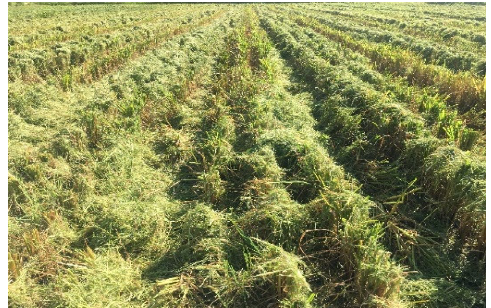
Figure 3. Stubble being covered by smashed straw.